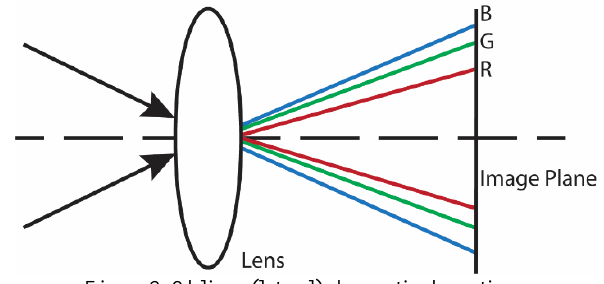
Figure 2. Oblique (lateral) chromatic aberrations.